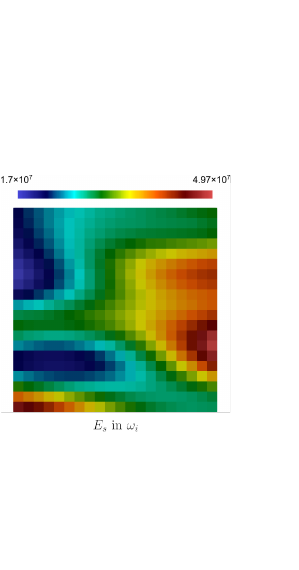
Figure 4. An example of the solid elastic modulus E s ( left ) and the first 4 offline multiscale basis functions for displacement in x 1 direction ( right ) in the local domain ω i .